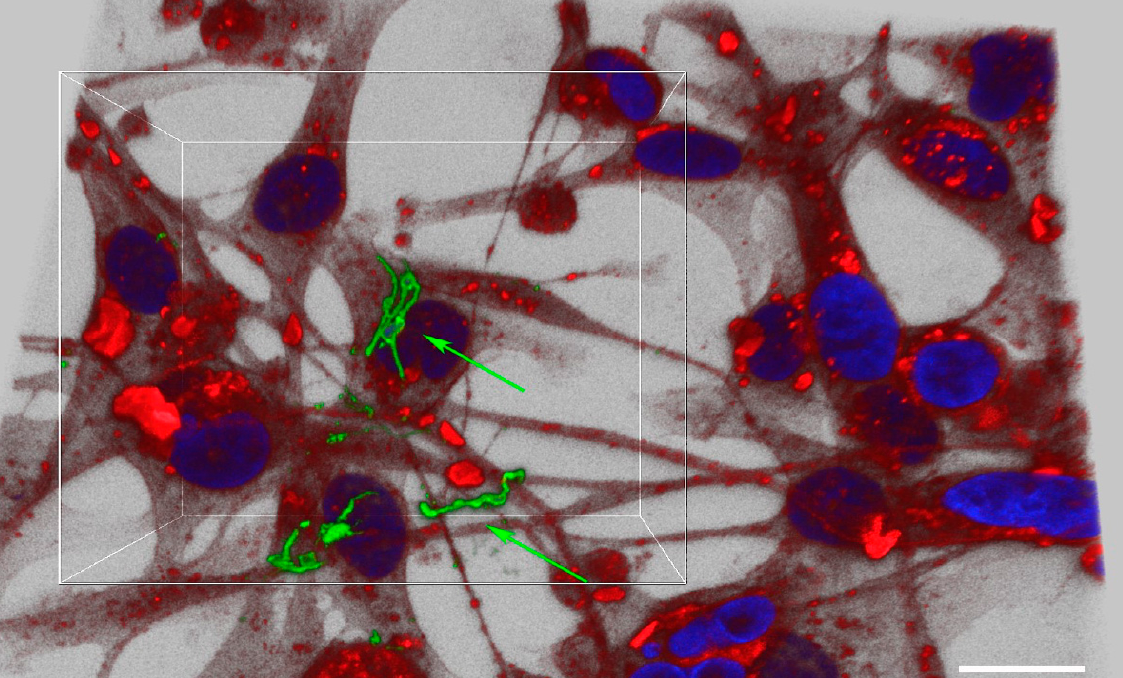
Figure 2. Analyses of B. burgdorferi localization in infected MDA-MB-231 mammalian epithelial using confocal microscopy. The cells were co-cultured with B. burgdorferi for 48 h. CM-Dil stain was used to label live cells (red), DAPI was used to stain the nucleus (blue) and polyclonal anti- B. burgdorferi was used to visualize B. burgdorferi (green) as described in the Material and Methods. The image was taken at 630X with a scale bar of 20 μ m. Table 1. Quantitative analysis of the number of the different mammary epithelial cell lines in-